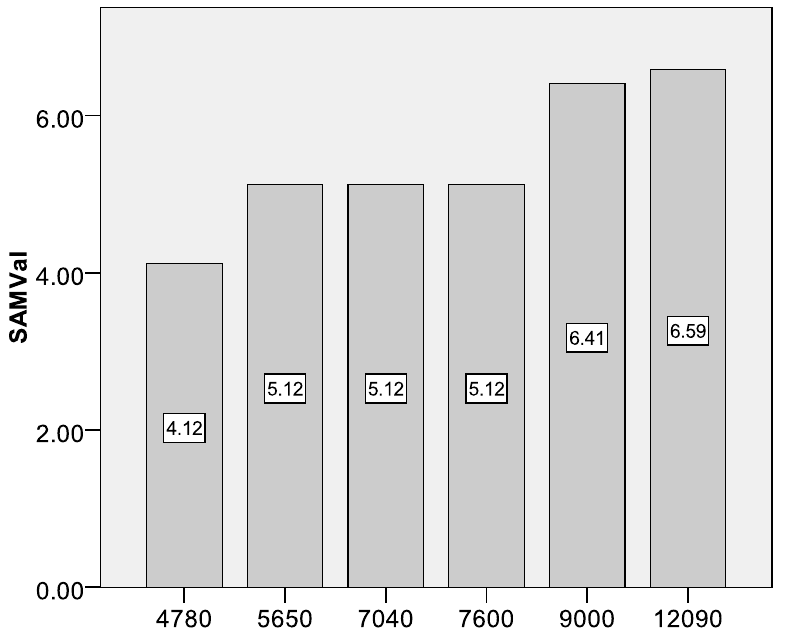
Figure 2. Subjective rating of pleasantness related to the six urban environments. Note, the higher the price the higher the subjective